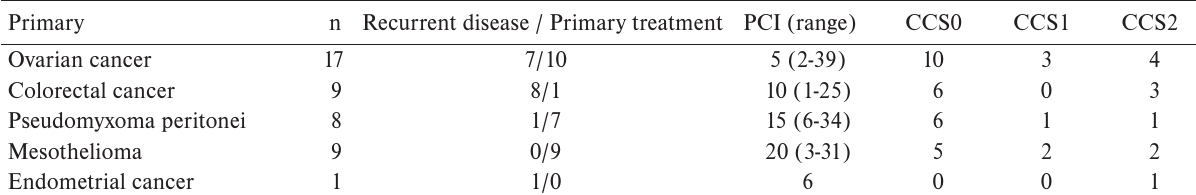
Table 1. Subgroups of patients according to the primary tumor.